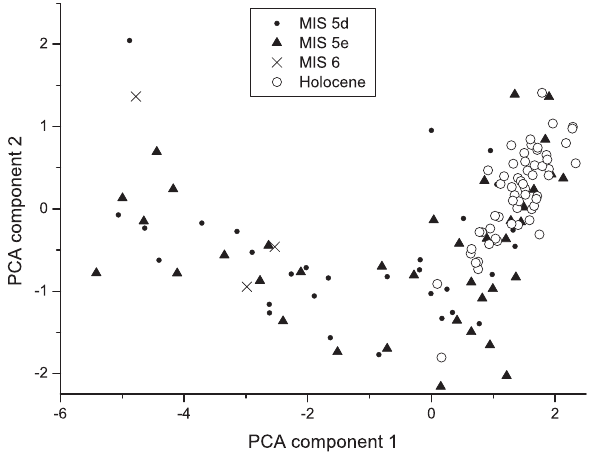
Fig. 7. Comparison of foraminiferal assemblages of MIS 6-5d and Holocene in core KL9 (most abundant species according to Siccha et al. (2009)). Plotted is PCA component 1 vs. PCA component 2. Overlapping areas display similar assemblages.